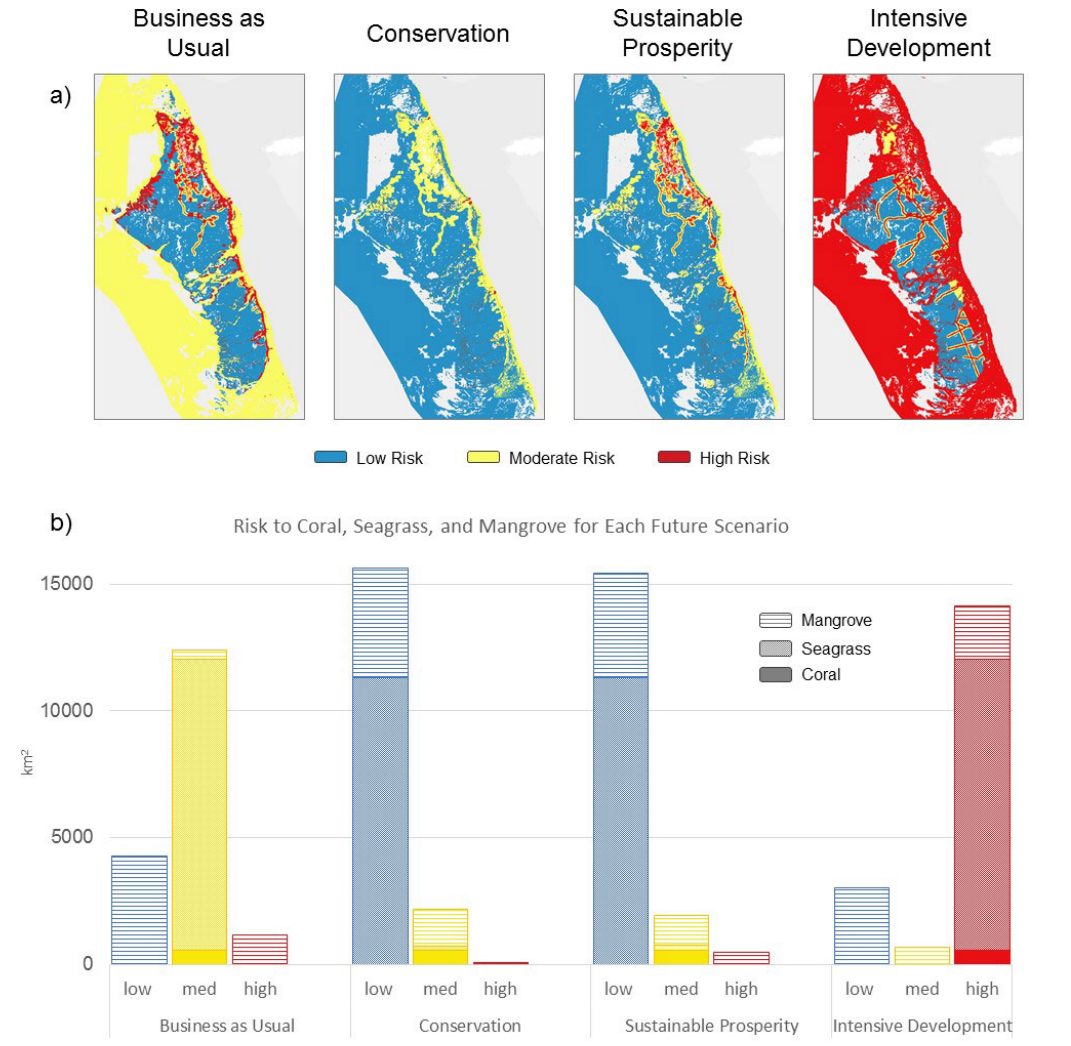
Fig. 6 . Habitat risk to mangroves, seagrass, and coral under each future scenario. Figure 2 shows the distribution of each of these habitats: mangroves occur across much of the island, seagrass in the waters around the island, and the coral reef runs parallel to the eastern shoreline. Risk to each habitat is spatially explicit based the location of activities and their relative exposure and consequence for each habitat (a). Total mangrove habitat is 5759 km², seagrass covers 11,491 km², and coral covers 552 km². Summarized across Andros, risk for all habitats is modeled to be greatest under the intensive development scenario (b). Risk is comparable between Conservation and Sustainable Prosperity scenarios, but slightly lower for mangroves under the Conservation